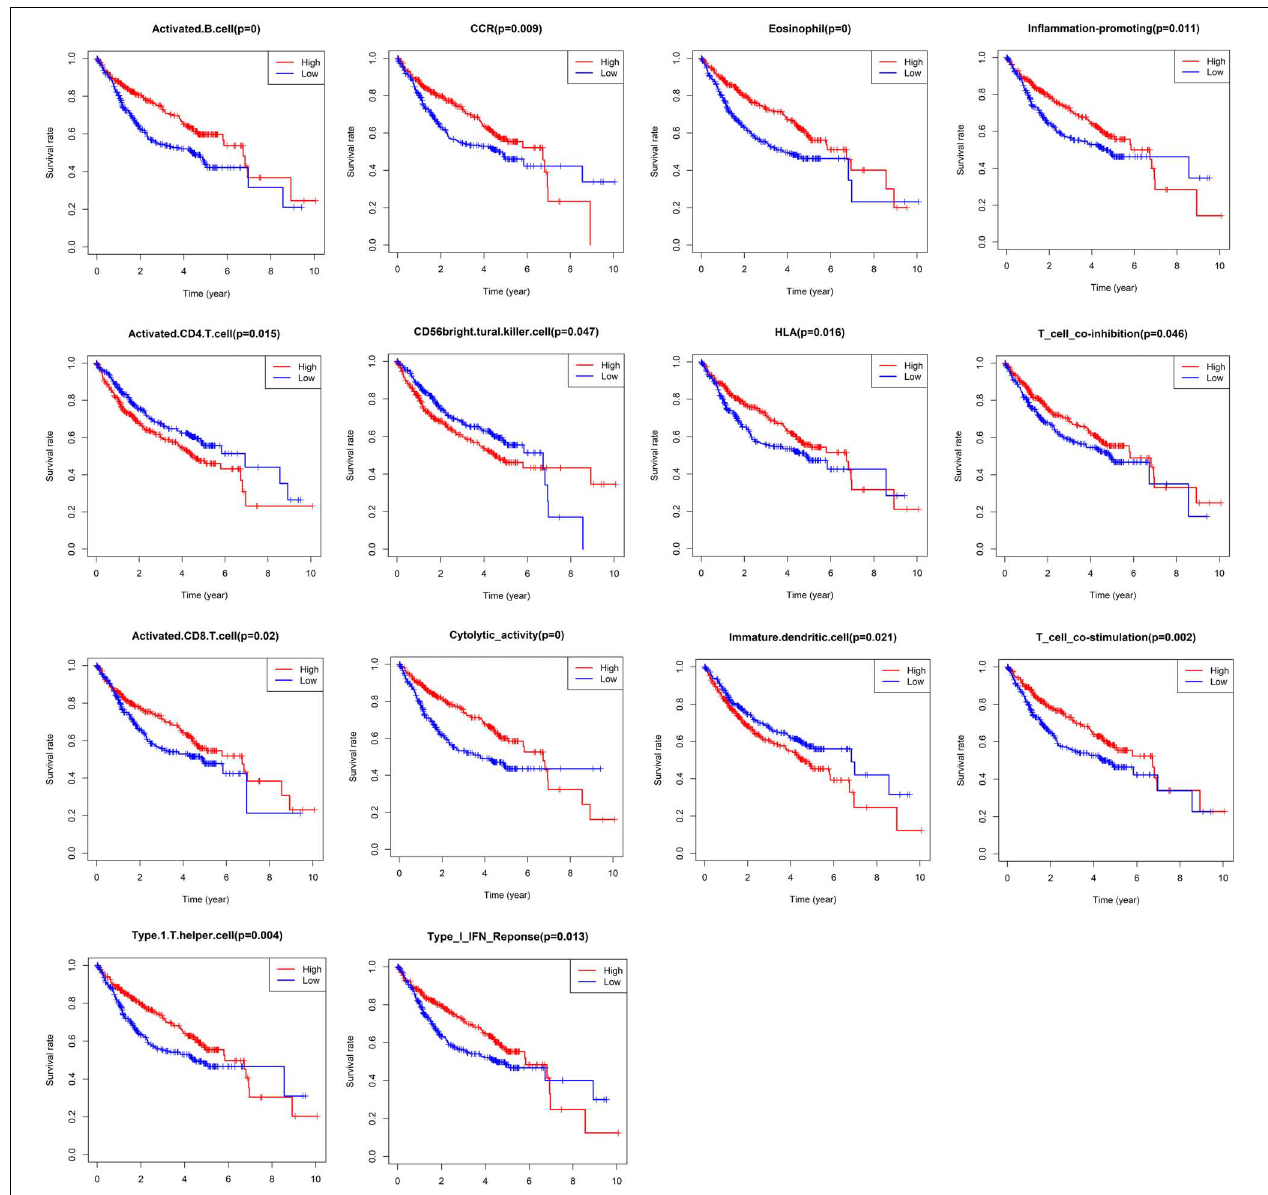
FIGURE 8 | The Kaplan–Meier survival analysis regarding immune cells infiltration and immune